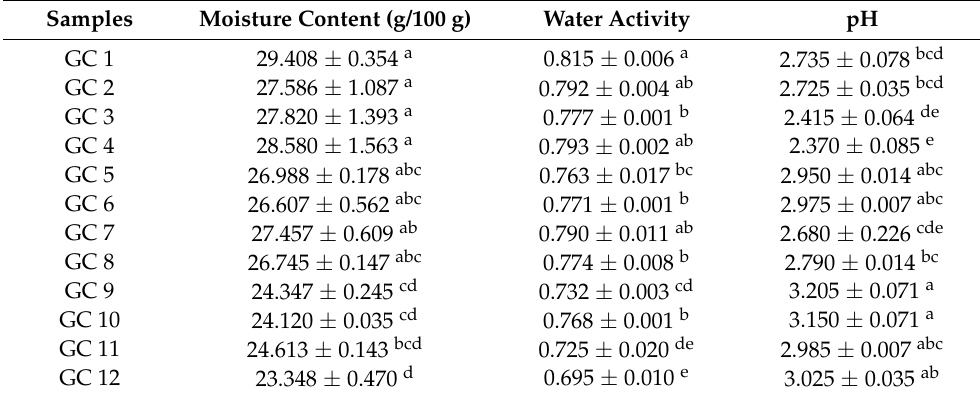
Table 3. Moisture content, water activity, and pH values of different